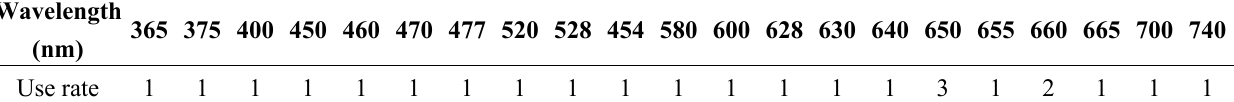
Table 1. Wavelength use rate in chlorophyll sample